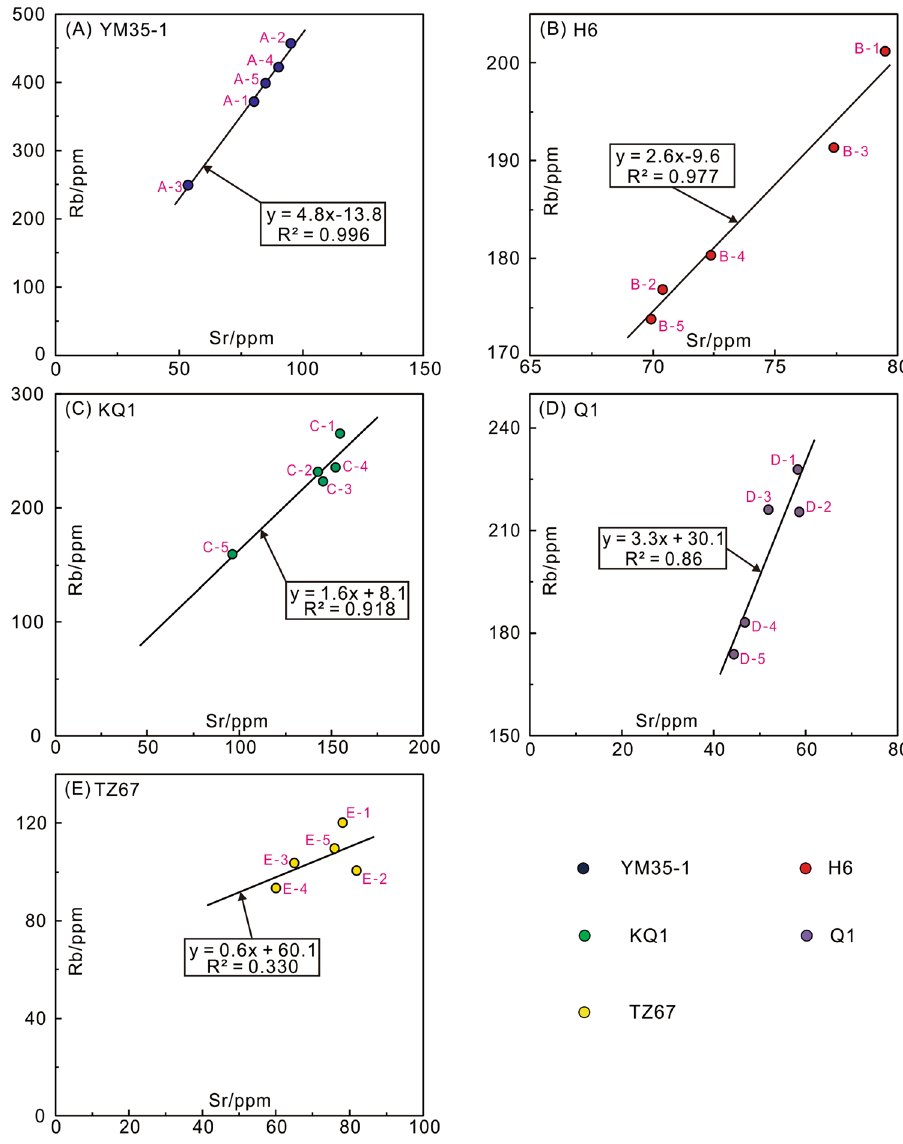
Figure 5. Scatter plots of Rb vs Sr contents. ( A ) YM35-1; ( B ) H6; ( C ) KQ1; ( D ) Q1; and ( E )